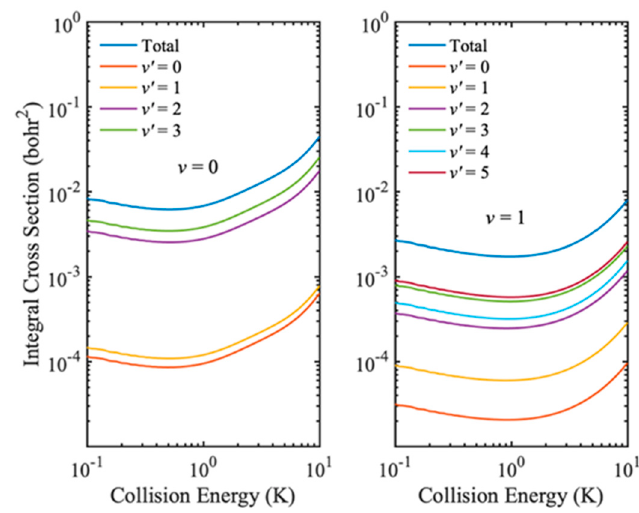
(cid:48) ) collisions. → Na(3s) + H 2 ( v = 0, 1) 2 ( v